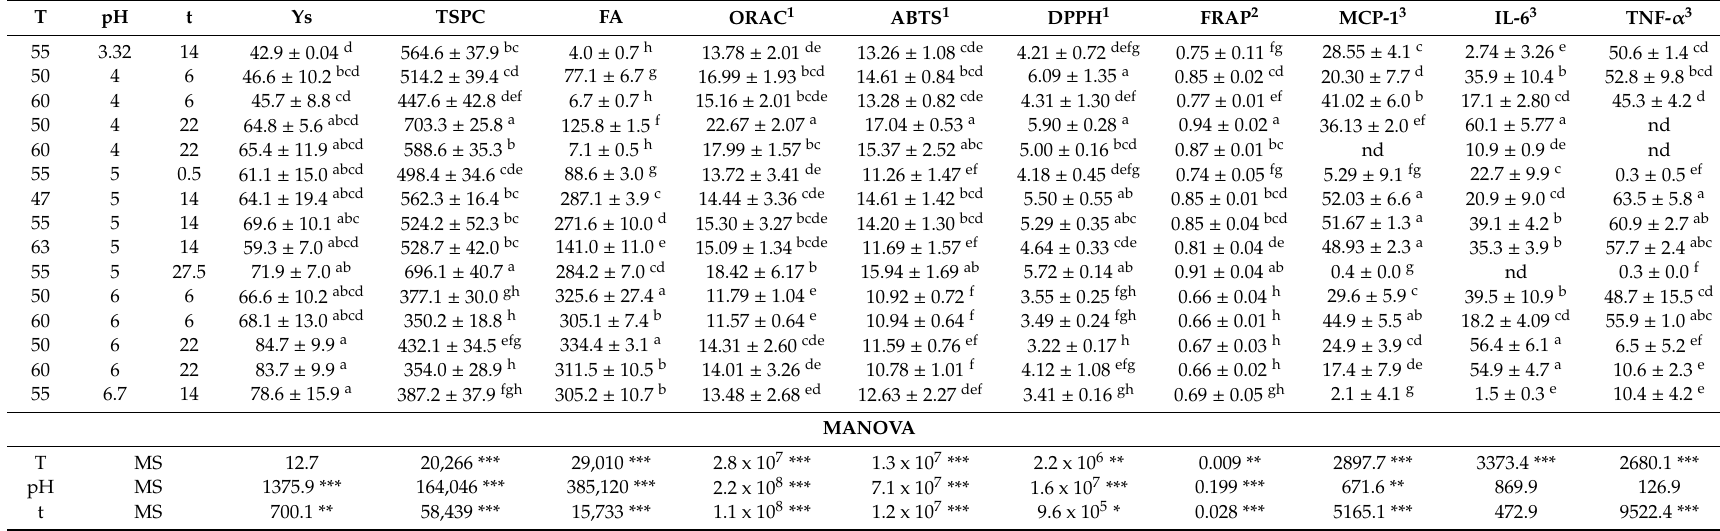
Table 4. Solubilization yield (Ys, %), TSPC (mg ferulic acid equivalents / 100 g hydrolysate [soluble fraction]), free ferulic acid (FA; mg / 100 g hydrolysate [soluble fraction]), and antioxidant and anti-inflammatory activities of WB hydrolyzed by Ultraflo XL under di ff erent conditions of temperature ( ◦ C), pH, and time